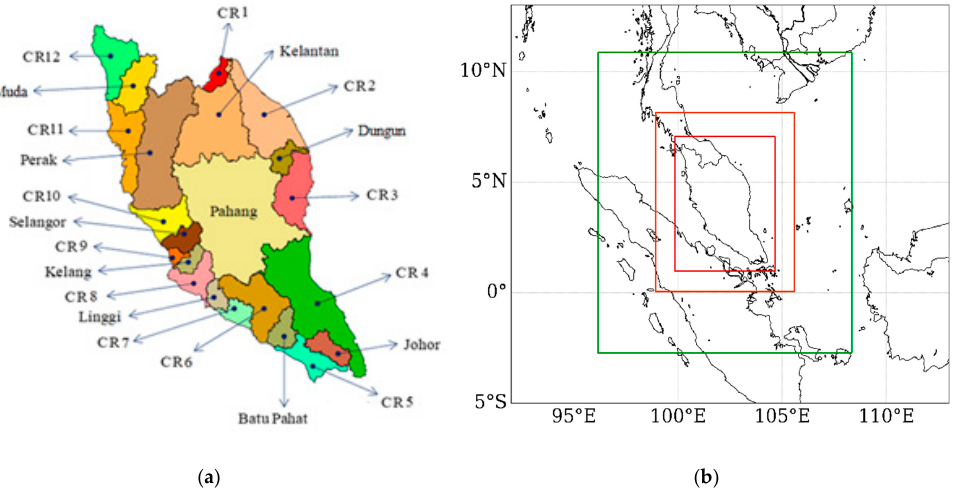
Figure 1. ( a ) 10 target watersheds and the remaining 12 coastal regions in Peninsular Malaysia ( b ) The modeling domains of Peninsular Malaysia hydroclimate model: The large outer domain shown by green box is covered by 54 km × 54 km grids; the intermediate domain shown by orange box is covered by 18 km × 18 km grids; and the inner modeling domain shown by red box is covered by 6 km × 6 km